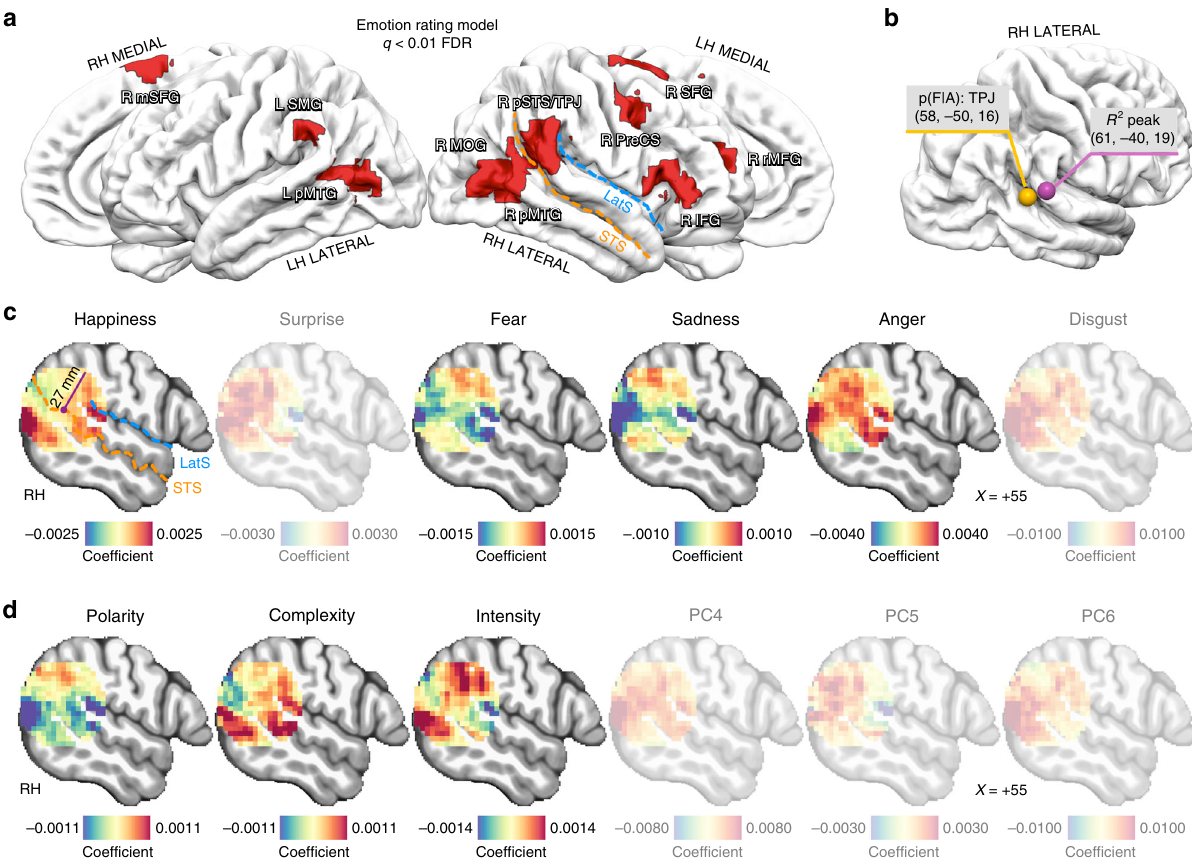
Fig. 3 Encoding of emotion ratings. a Brain regions encoding emotion ratings corrected for multiple comparisons using the False Discovery Rate method ( q < 0.01; voxelwise encoding permutation test; n = 3595 timepoints). b Peak of association between emotion ratings and brain activity (purple sphere) and reverse inference peak for the term TPJ as reported in the NeuroSynth database (yellow sphere). Coordinates represent the center of gravity in MNI152 space. c β coef fi cients associated to basic emotions in a spherical region of interest (27 mm radius) located at the reverse inference peak for the term TPJ. Maps for emotions not consistent across all the subjects (i.e., surprise and disgust) are faded. d β coef fi cients associated to emotion dimensions in a spherical region of interest (27 mm radius) located at the reverse inference peak for the term TPJ. Maps for components not consistent across all the subjects (i.e., PC4, PC5 and PC6) are faded. IFG inferior frontal gyrus, rMFG rostral middle frontal gyrus, mSFG medial superior frontal gyrus, preCS precentral sulcus, pSTS/TPJ posterior part of the superior temporal sulcus/temporo-parietal junction, MOG middle occipital gyrus, pMTG posterior middle temporal gyrus, SMG supramarginal gyrus, LatS lateral sulcus, STS superior temporal